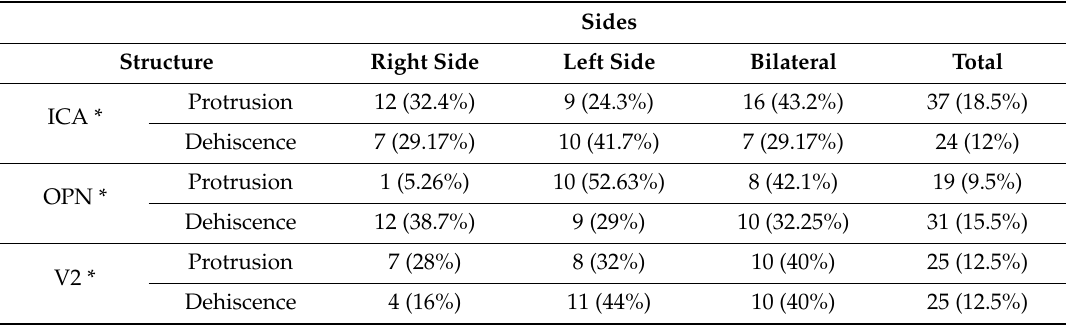
Table 3. Summary of relationship of internal carotid artery, optic nerve and foramen rotundum to the sphenoid sinus.